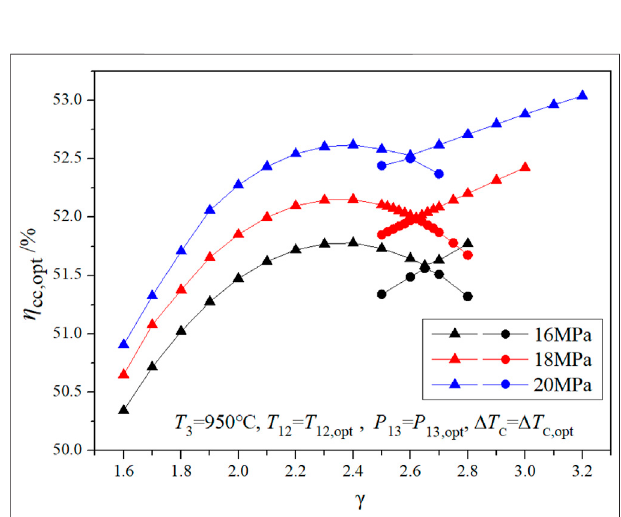
FIGURE 11 | Extreme ef fi ciency values of the combined cycle under different main steam